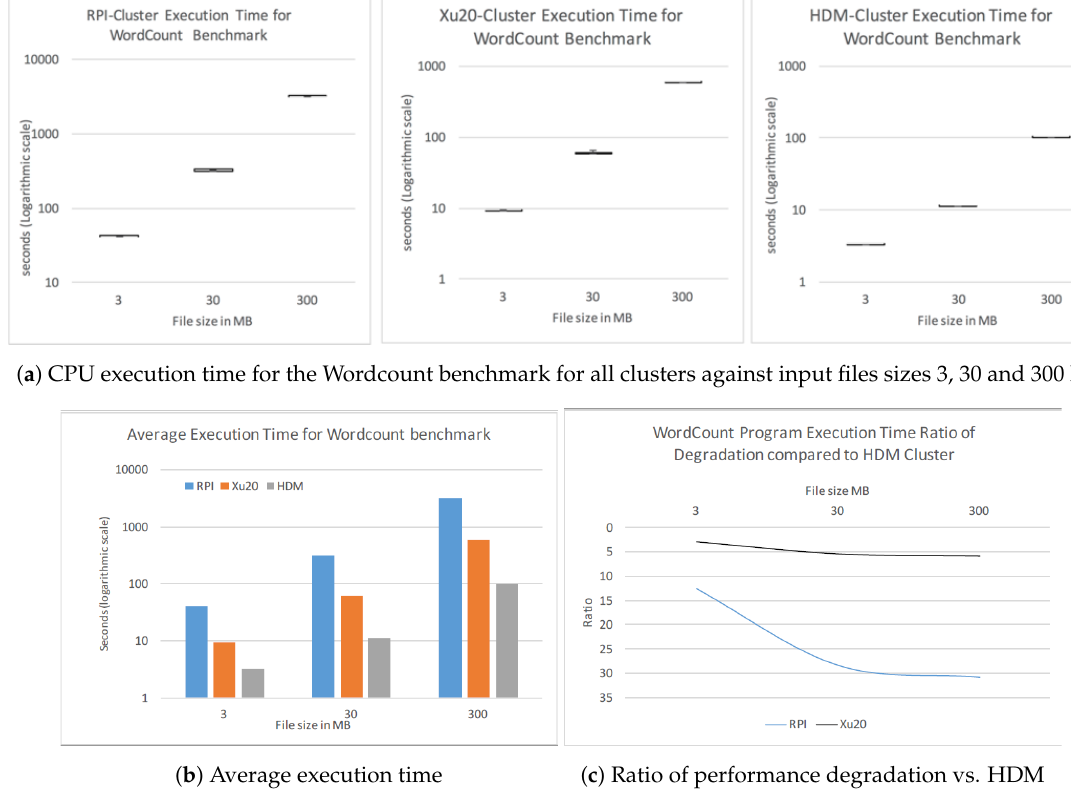
Figure 4. Wordcount